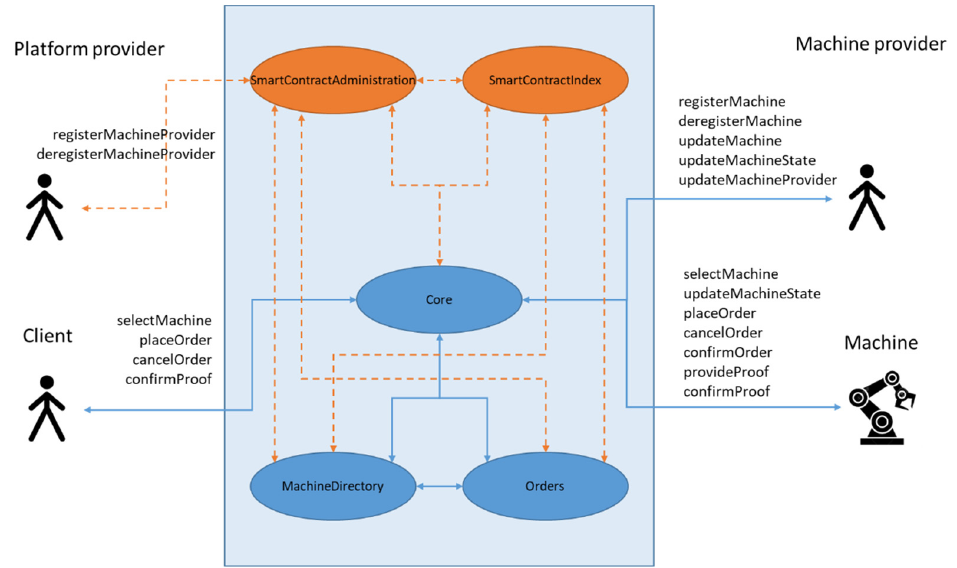
Figure 3. Top-level smart contract layout and actors.